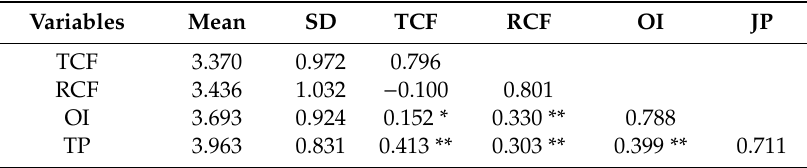
Table 5. Mean, standard deviation, and correlation matrix.